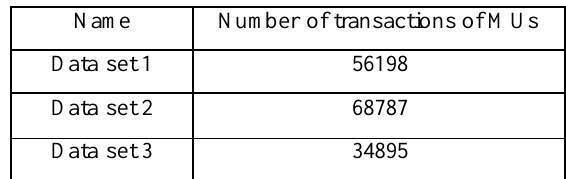
Table 5. Training data